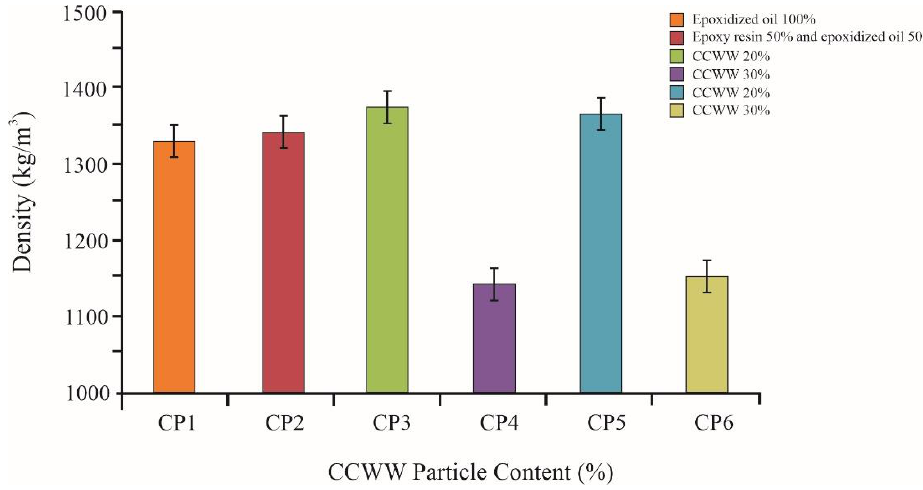
Figure 3. Density of particleboards as a function of CCWW contents.